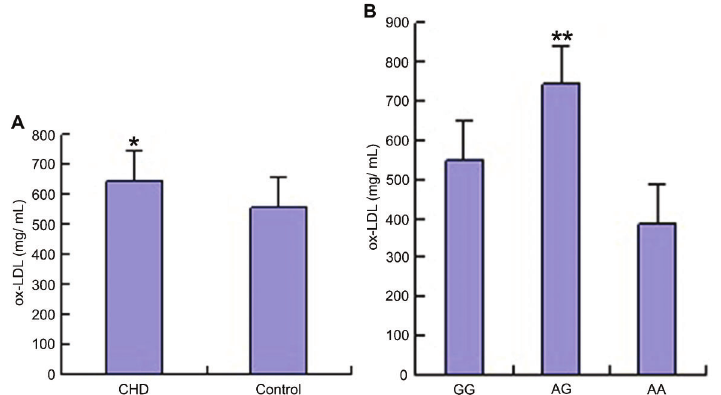
Figure 5. Plasma level of ox-LDL between coronary artery heart disease (CHD) patients and healthy controls. A. The plasma level of ox- LDL in CHD patients (646.24±369.99 m g/L) was significantly higher than that of healthy controls (555.91±283.68 m g/L), with *P=0.037. B , There were significant differences in the plasma levels of ox-LDL in CHD patients with different geno- types of rs1761667 (**P=0.010); and the plasma levels of ox-LDL in CHD patients with AG genotype (741.38±418.39 m g/L) were signifi- cantly higher than those with GG and AA genotypes (551.01±271.41 m g/L, P=0.009; 386.35±201.52 m g/L, P=0.034, respectively). No significant differences were observed in plasma levels of CHD patients with GG and AA genotypes (P=0.523). The t -test was used for statistical